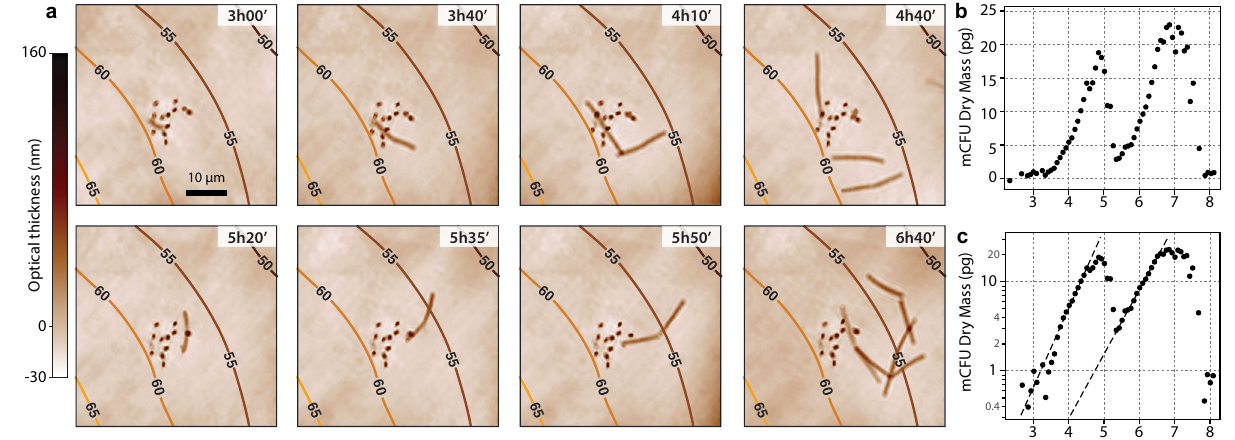
stearothermophilus aggregate. c Plot of ( b ) in semi-log scale to highlight the linear fi ts giving the growth rates (dashed lines).